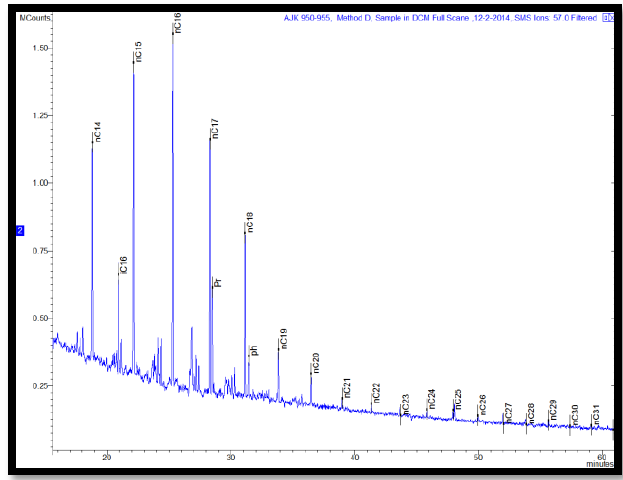
Figure 6: Chromatogram of Laki Formation shale extracts showing distribution of alkanes (m/z 57).